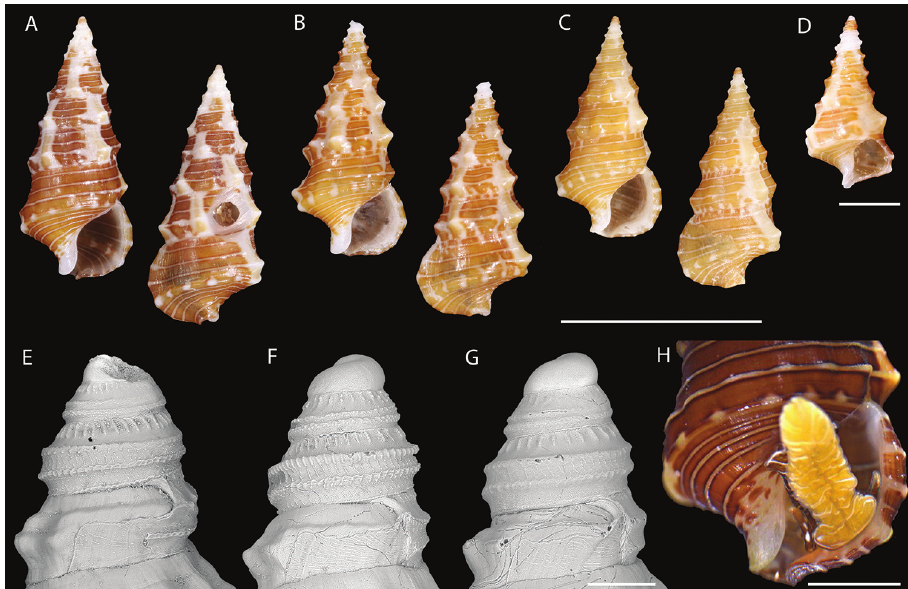
Figure 2. Shell and external morphology of Limatium pagodula sp. n. A Holotype, UF 427943. French Polynesia, Society Islands, Moorea B Paratype, USNM 1462731. Tuamotu Islands, Makemo, Pohue (ex. coll. Letourneux) C Paratype, MNHN IM-2014-6933. Vanuatu, Santo, W. of Tutuba I., SANTO 2006 stn. DS104 D Subadult. Tuamotu Islands, Makemo, Arikitamiro (coll. Letourneux) E Protoconch, USNM 1462729. Tahiti, grotte du chenal d’Arue (ex. coll. Letourneux) F Protoconch. Tuamotu Islands, Makemo, Arikitamiro (coll. Letourneux) (same as in 2D) G Protoconch, Tuamotu Islands, Makemo, Arikitamiro (coll. Letourneux) H Living animal, holotype UF 427943. French Polynesia, Society Islands, Moorea. Scale bars: 5 mm ( A–C ); 1 mm ( D, H ); 100 µm ( E–G ). Limatium aureum sp.